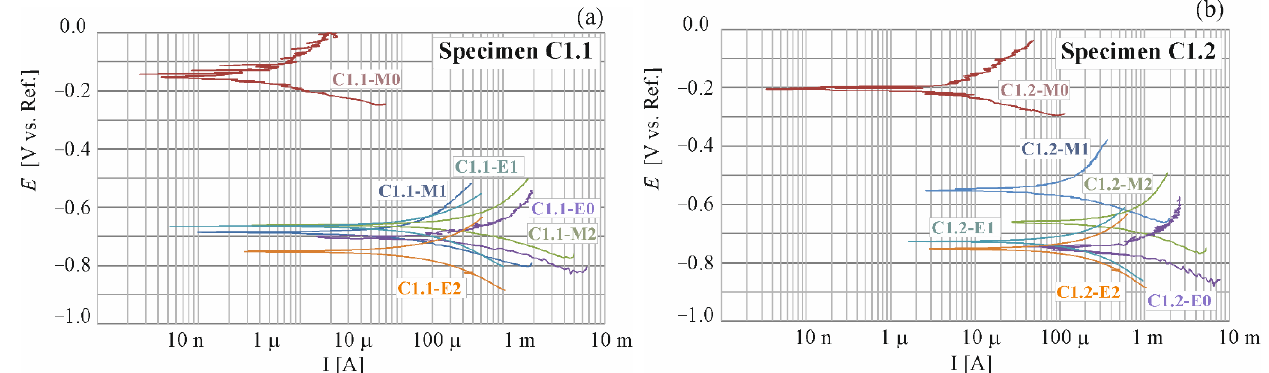
Figure 4. Potentiodynamic polarization curves for steel reinforcement in concrete C1 obtained for selected specimens: ( a ) C1.1 and ( b ) C1.2; M0 before chloride migration, M1 after 7 days, M2 after